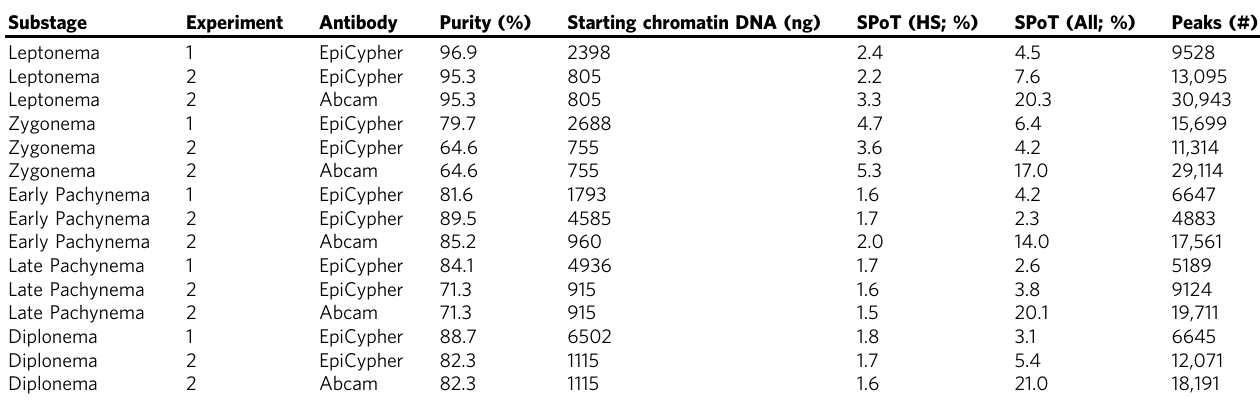
Table 1 Summary of cell-type-speci fi c H3K4me3 ChIP-Seq Substage